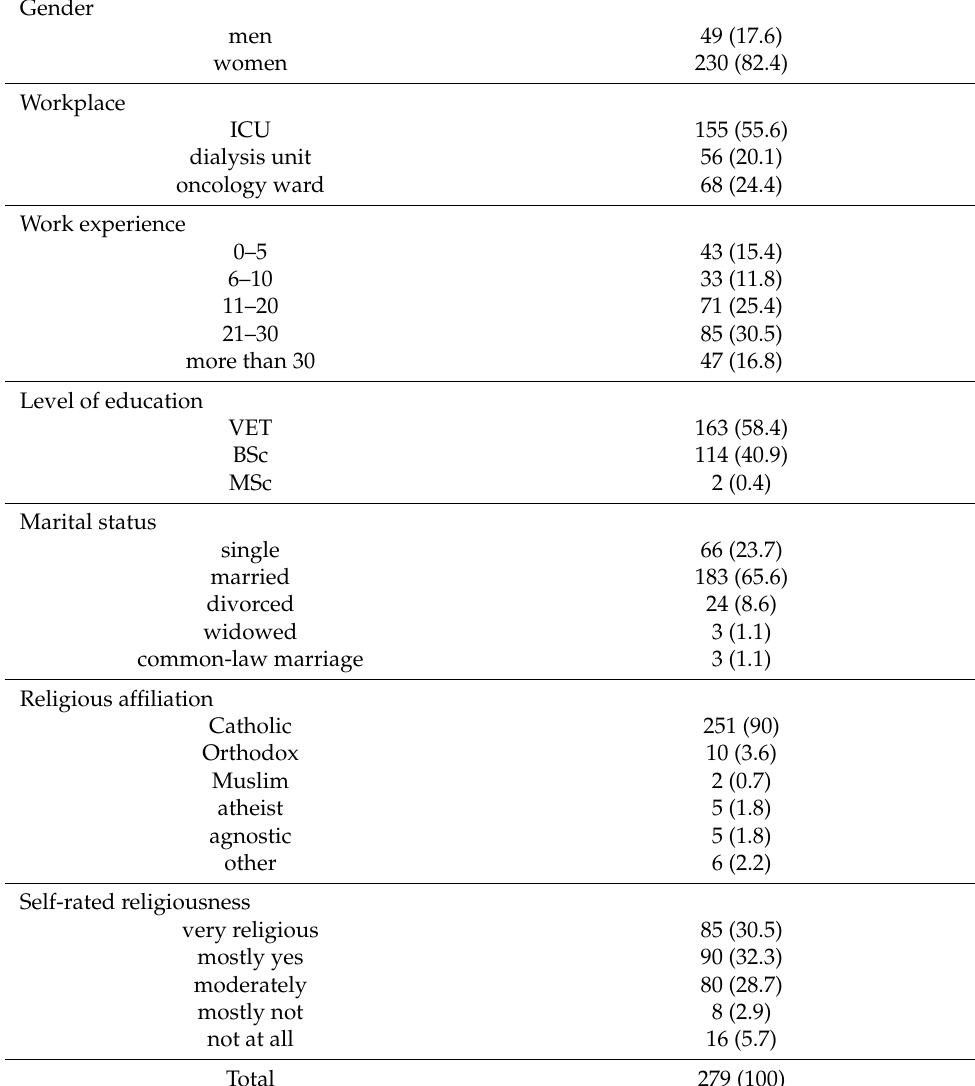
Table 1. Socio-demographic Characteristics of Respondents (n =